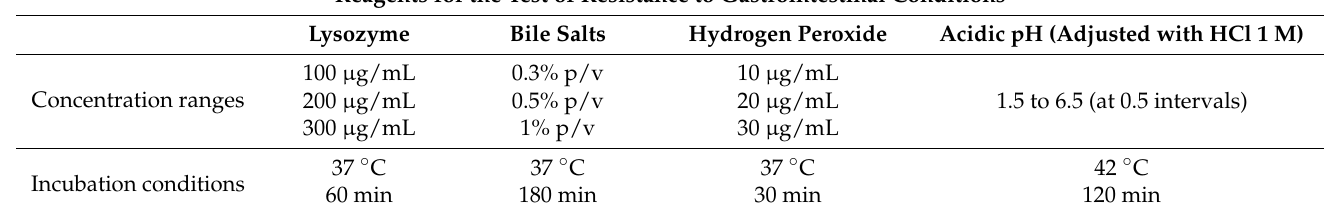
Table 1. Concentration of reagents and incubation conditions for the evaluation of the resistance of lactic strains to gastrointestinal conditions [23]. Reagents for the Test of Resistance to Gastrointestinal Conditions Lysozyme Bile Salts Hydrogen